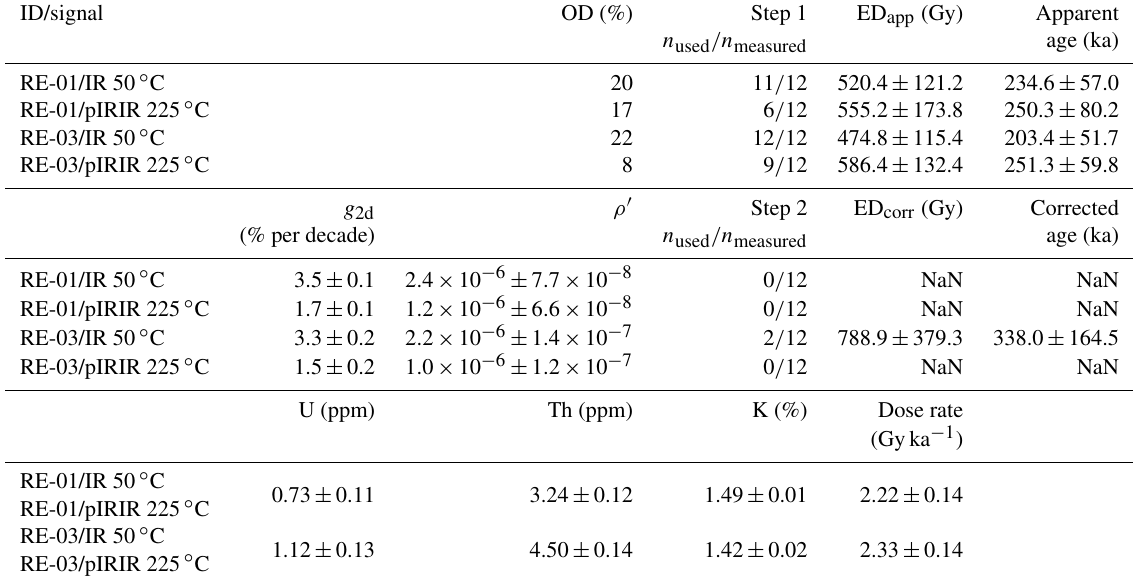
Table 3. Details of the IR50 and pIRIR225 luminescence analyses of samples RE-01 and RE-03, including the details of the first step analysis of the apparent (i.e., uncorrected) D e , the details of the second step analysis for fading correction (Kars et al., 2008), and inputs for the calculation of the natural dose with DRAC (Durcan et al., 2015). The table has “NaN” (not a numeric) entries where age calculations were attempted but failed due to the elimination of saturated